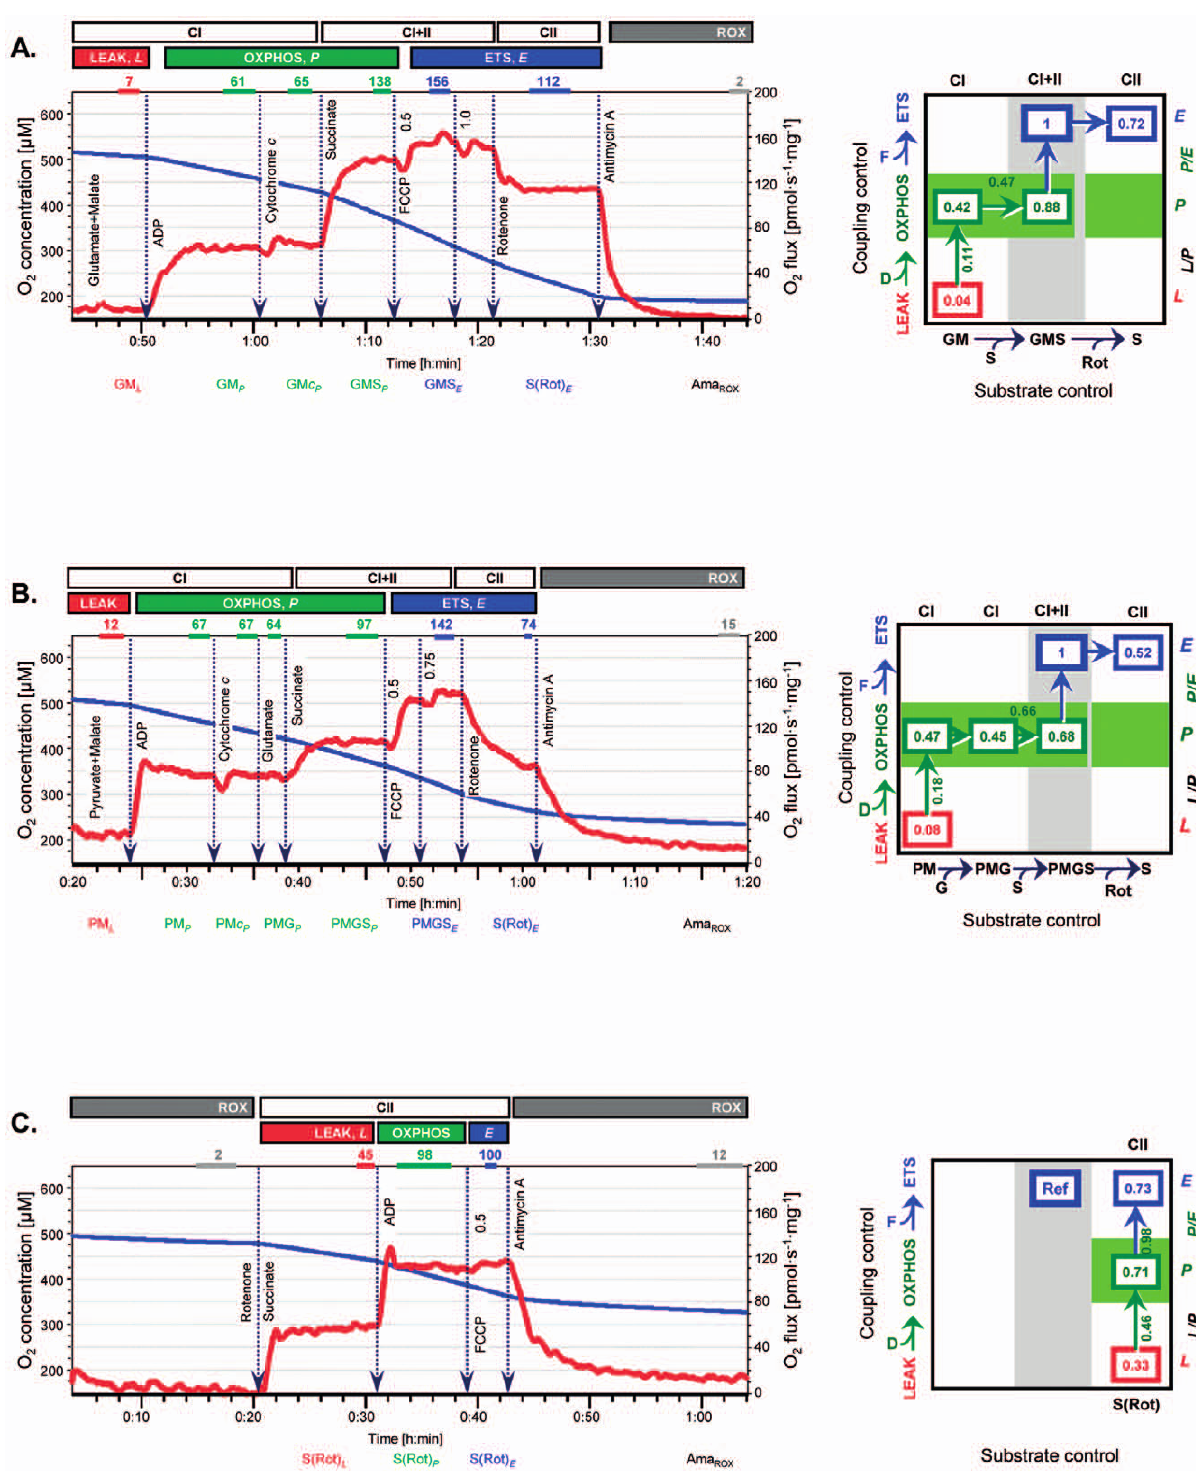
Figure 1. Respirometric protocols with permeabilized fibres from horse skeletal muscle ( tricepsbrachii ). A : SUIT1 protocol with electron flow through CI supported by glutamate + malate. B : SUIT2 protocol with electron flow through CI supported by pyruvate + malate. C : SUIT3 protocol with electron flow through CII. Leftpanels: Oxygen concentration ( m M; blue lines) and muscle mass-specific oxygen flux (pmol O 2 ? s 2 1 ? mg 2 1 wet weight; red lines). Marked sections correspond to steady-state fluxes at different coupling states ( L , P and E ) and substrate states. Numbers on top of traces are ROX-corrected tissue mass-specific fluxes at various metabolic states, and ROX (pmol O 2 ? s 2 1 ? mg 2 1 ). Rightpanels: Coupling/substrate control diagrams with flux control ratios ( FCR ) normalized relative to ETS capacity with convergent CI + II electron input (values framed). Values linked to vertical and horizontal arrows are coupling control ratios ( L/P and P/E ratio), and substrate control ratios (CI/CI + II in the OXPHOS state). FCR linked by arrows directly to the reference state are also coupling control ratios ( P/E ) or substrate control ratios (CII/CI + II). Whereas internal FCR are obtained